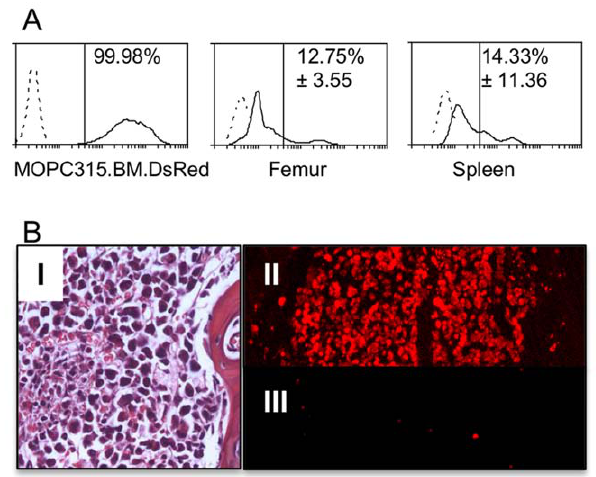
Figure 5. Flow cytometry and histology of MOPC315.BM DsRed cells injected i.v. in C.B-17 SCID (5 6 10 6 ) and BALB/c mice (1 6 10 6 ). (A) Upper left: Flow cytometric histograms of MOPC315.BM DsRed cells (solid line) and as a control MOPC315.BM cells (dashed line). Flow cytometry from a representative paraplegic C.B-17 SCID mouse. Upper right: Femur cells (solid line) and normal femur (dashed line). Lower right: spleen (solid line) and normal spleen (dashed line). The average and standard deviations for each organ are shown on each plot. Backgrounds in a non-injected mouse (to the right of the vertical line) were for femur 1.34% and spleen 1.68%. (B) I: H&E staining from a femur of a paraplegic BALB/c mouse. II: Fluorescence microscopy of sections of same femur. III: Femur from a mouse injected with non- fluorescent MOPC315.BM (control).